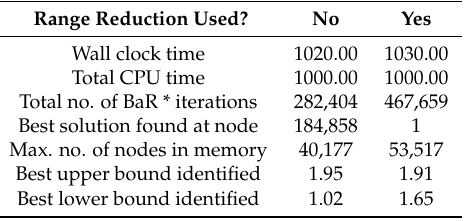
Table 4. The results of BARON v18.5.8 in GAMS when applied to (9), with 1000 s of solver time allocated in each